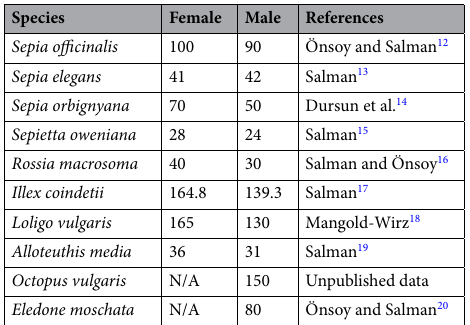
Table 1. Dorsal mantle lengths (in mm) of the species at which 50% of the population reaches maturity ( N/A not